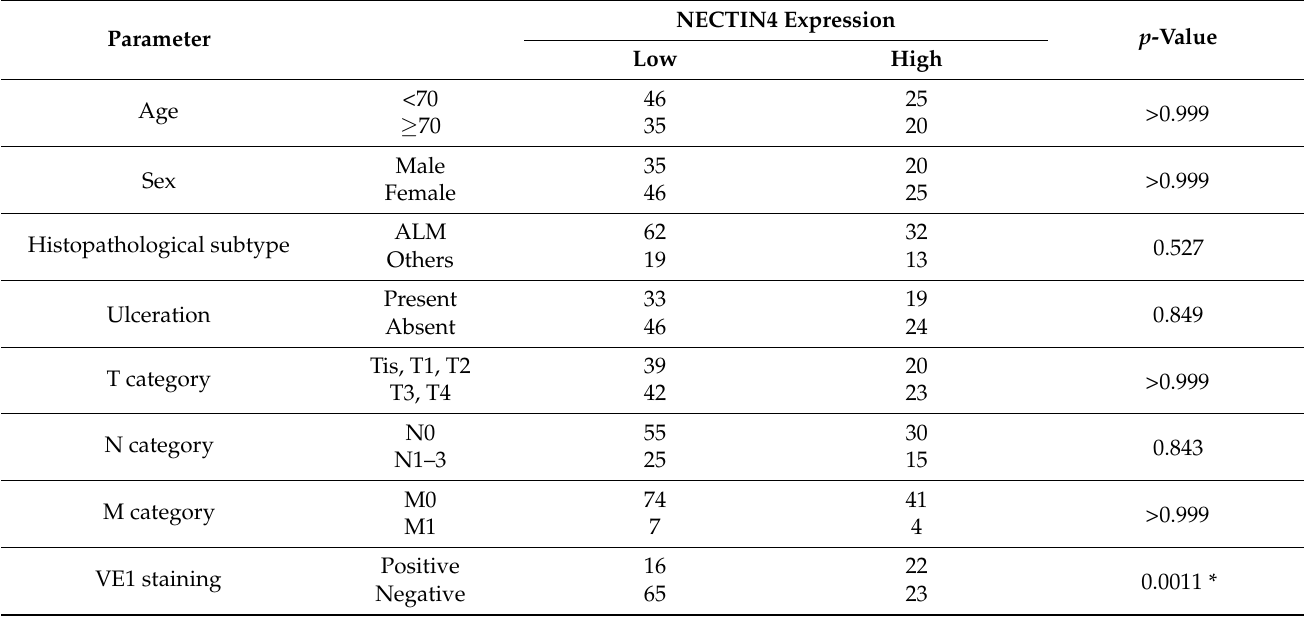
Figure 1. NECTIN4 is expressed in melanoma tissues and is associated with BRAF mutation. Immunohistochemical staining of NECTIN4 in a patient’s tumor tissue. ( a ) Representative images from 126 melanoma samples are shown. The intensity of the staining was classified on a scale from 0 to 3+: no staining (0), weakly positive (1+), moderately positive (2+), and strongly positive (3+). Black arrows indicate NECTIN4-positive cells. Scale bar = 100 µm. ( b – d ) Survival curve of NECTIN4 expression intensity and ( b ) disease-free survival, ( c ) melanoma-specific survival, and ( d ) overall survival ( n = 126). Patients’ survival was calculated using the Kaplan–Meier method and the log-rank test. p < 0.05 was considered to indicate a statistically significant difference. Table 2. Factors associated with NECTIN4 expression.